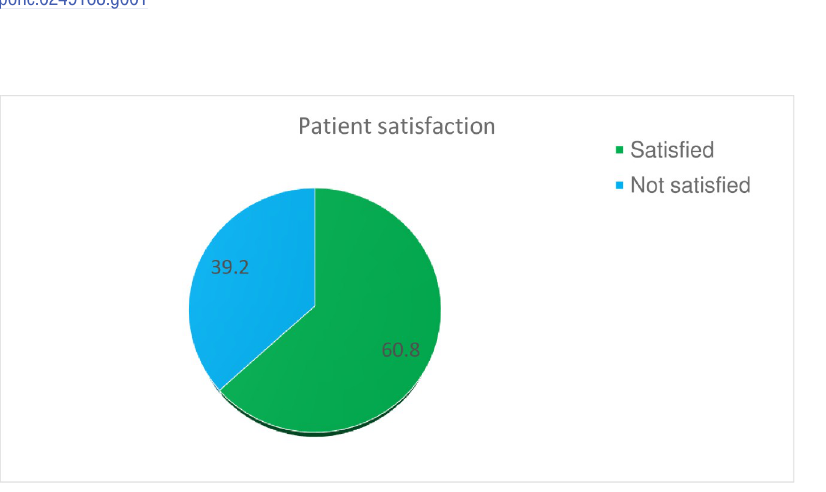
Fig 2. Overall satisfaction of patients admitted to Pawie General Hospital Benishangul Gumuze Region, West Ethiopia, 2020 (n = 334).